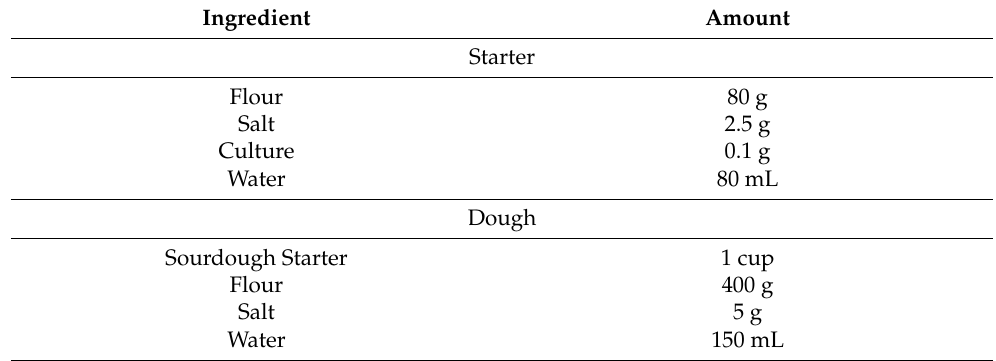
Table 1. Formulation used to make the six sourdough bread